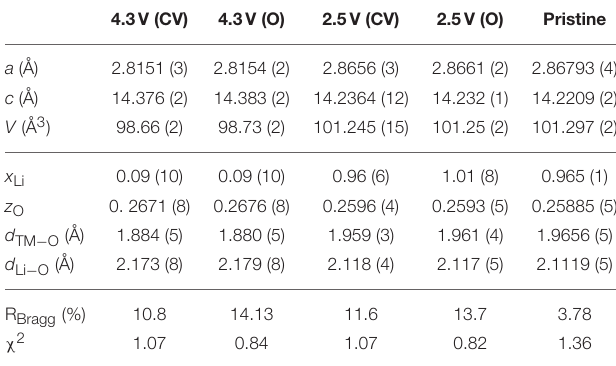
TABLE 2 | Refined crystal structure parameters obtained from the Rietveld refinement using the background-corrected neutron diffraction data collected at constant voltage (CV), in operando (O), and for the pristine powder (values taken from Table 1 ).